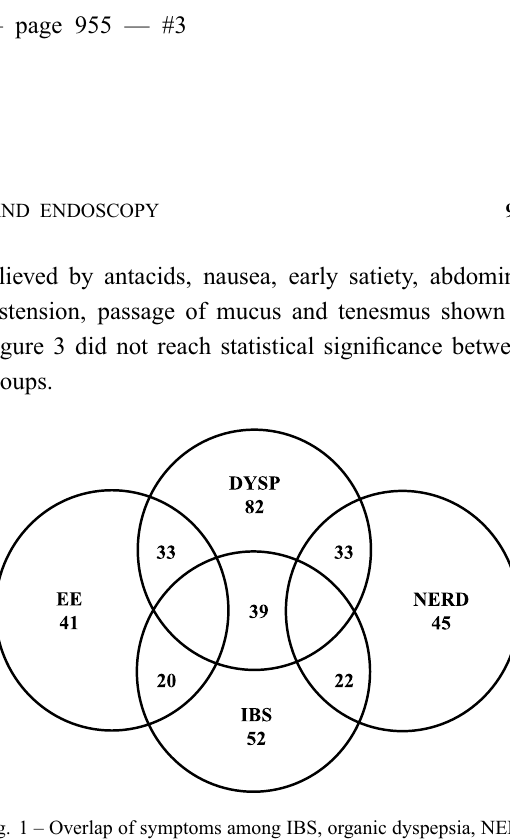
Fig. 1 – Overlap of symptoms among IBS, organic dyspepsia, NERD and EE in 118